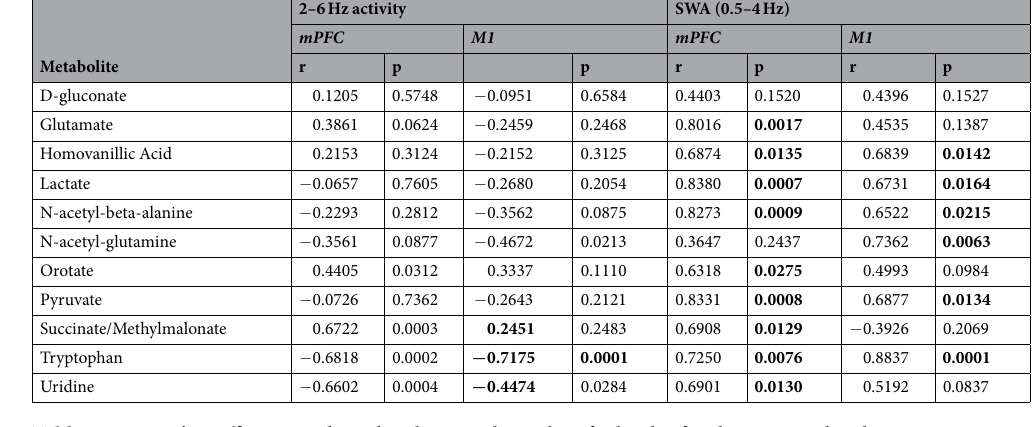
Table 2. Pearson’s coefficients and p-values between log-values for levels of each compound and 2–6 Hz activity or SWA. Values in bold are the ones surviving the correction for multiple comparison (Benjamini-Hochberg, 1995).